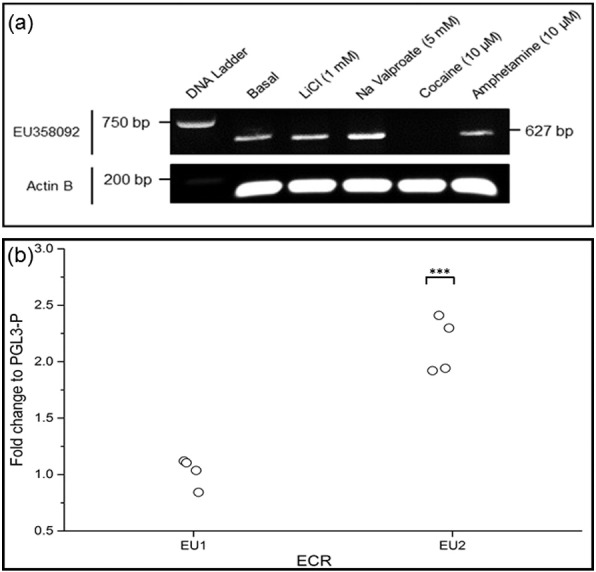
Activity of the EU358092 locus in vitro.(a) Expression of EU358092 was addressed in vitro by PCR of cDNA from SH-SY5Y under basal conditions, and after the following treatments: lithium chloride (1 mM), sodium valproate (5 mM), cocaine (10 μM), and amphetamine (10 μM). Actin B was used as an internal control. EU358092 was shown to be expressed under basal conditions in SH-SY5Y neuroblastoma cells, with expression upregulated following treatment with sodium valproate, and strongly downregulated following cocaine treatment. This pattern of expression in response to challenge was also seen for MIR137 (Warburton et al., 2015b) and may suggest related regulatory responses of transcripts at this locus.(b) Regulatory function of ECR sequences was assessed by dual luciferase assay in the pGL3-Promoter (pGL3P) vector in SH-SY5Y neuroblastoma cells under basal conditions. EU358092 ECR 2 (EU2) supported a 2.12-fold increase in reporter gene expression compared to baseline expression from the empty pGL3P vector, supporting a regulatory role for this sequence, which may act upon the EU358092 promoter to modulate gene expression. EU1 displayed no regulatory function in this assay, which is consistent with this region displaying evolutionary conservation because it encodes the first exon of the EU358092 transcript, rather than being a conserved regulatory element. N = 4; ***p < 0.001.